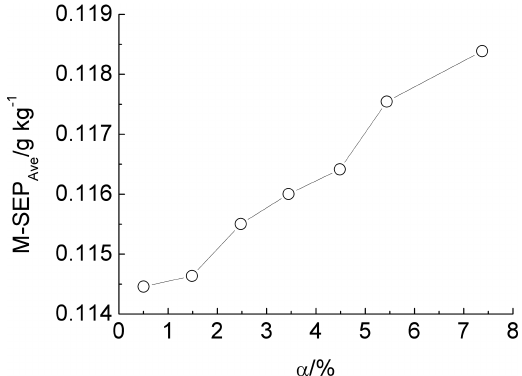
Fig. 3. Relationship between average prediction e®ects and average similarity degree of each division group.